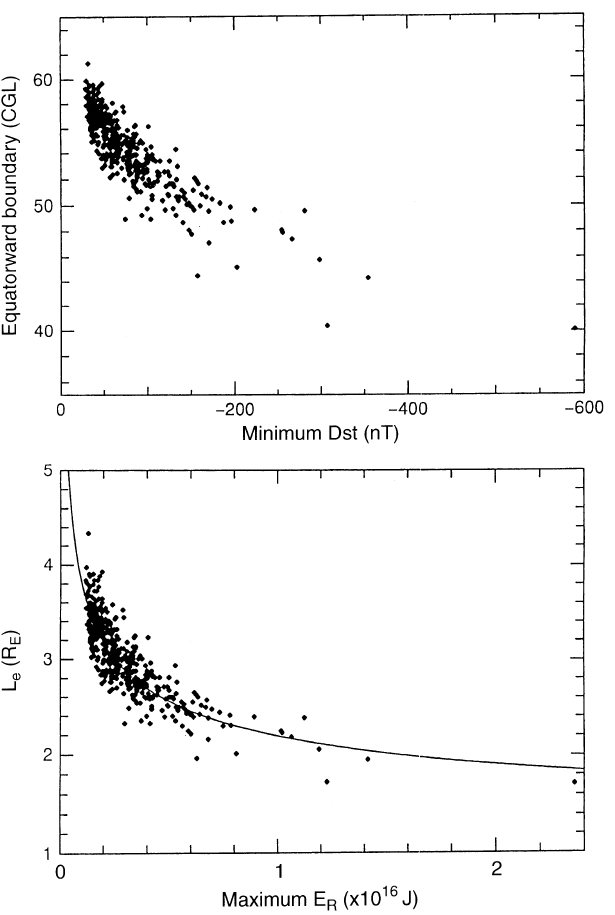
Fig. 3. Top the relationship between the minimum Dst value and the Fig. 4. Top correlation between the ring current energy and the equatorwardmost latitude of the auroral belt boundary for all 423 boundary index for the very intense storm of March 13–14, 1989. storms. Bottom the relationship between the ring current energy and Bottom open circles and crosses show the main phase and recovery the L -value corresponding to the auroral boundary. The regression phase, respectively. For the main phase (shown by open circles ), the curve indicates the relation L (cid:255) 3 time development is traced by connecting two / E R e